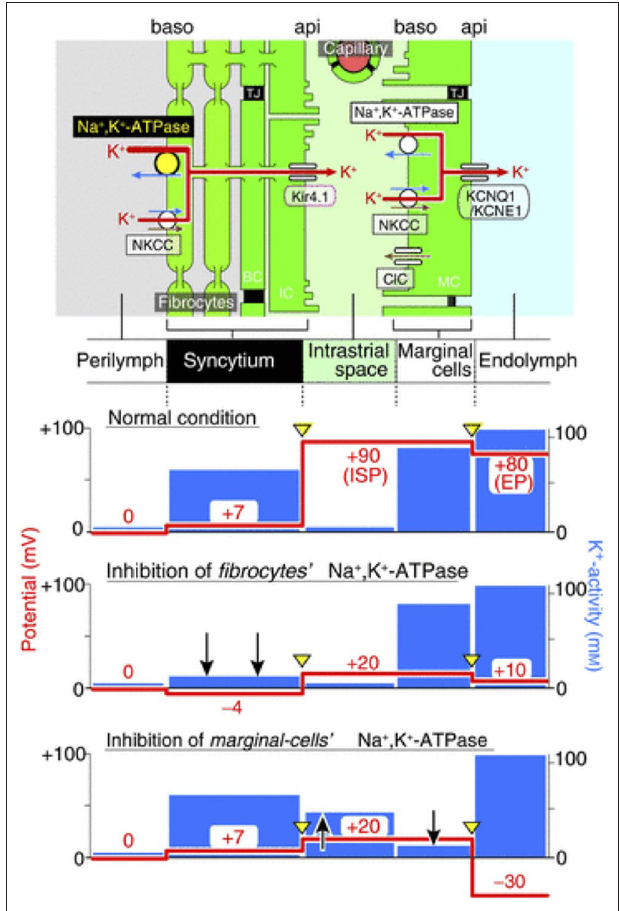
FIGURE 3 | Representation of the electrochemical milieu in the lateral wall (17) Top, scheme of the lateral wall and K + transport apparatus involved in the generation of the endocochlear potential. The other panels show the predicted potential and K + activity in each compartment under normal circumstances (second panel), during inhibition of Na,K/ATPase of SLFs (third panel) and during inhibition of Na,K/ATPase in marginal cells (fourth